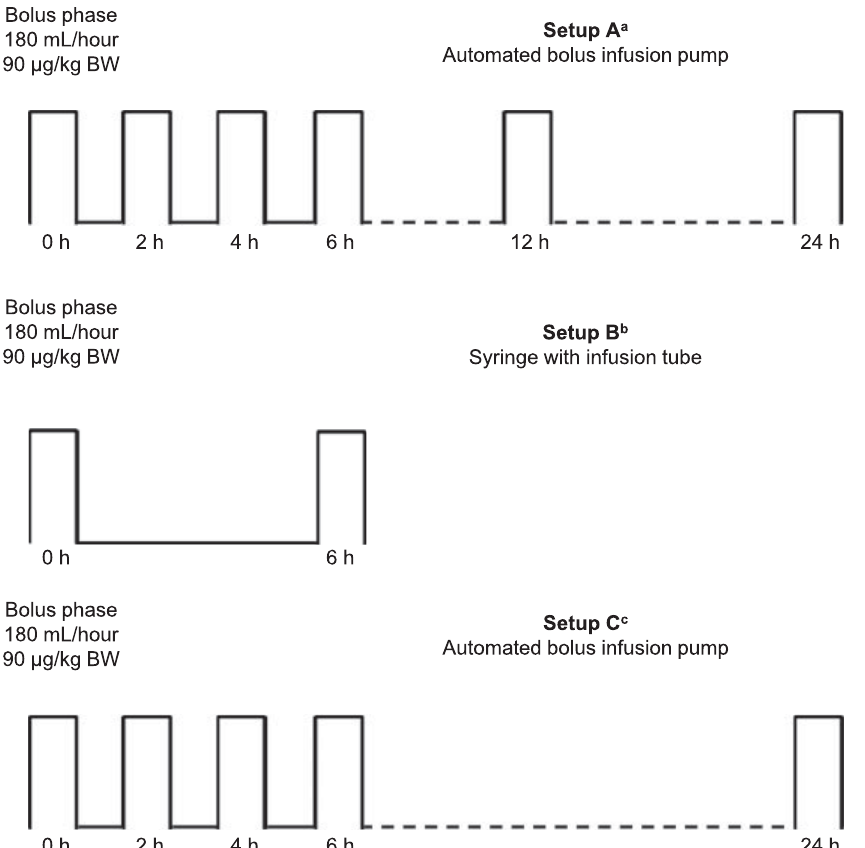
Fig. 1 Sampling plan for test systems. All test systems started with initial bolus sample of 2 mL at 180 mL/hour. a Programmed to deliver 0.01 mL/hour rFVIIa until next bolus sample, to simulate no dosing between bolus injections; b Tested separately without automated pump, with manual handling of syringe and infusion tube at same rate as automated bolus infusion pump (180 mL/hour); c Additional batches of rFVIIa tested. As only limited variations were observed between time points in the fi rst part of the study, fewer time points were used; sampling at 12 hours was omitted. BW, body weight; h, hour; rFVIIa, recombinant activated factor